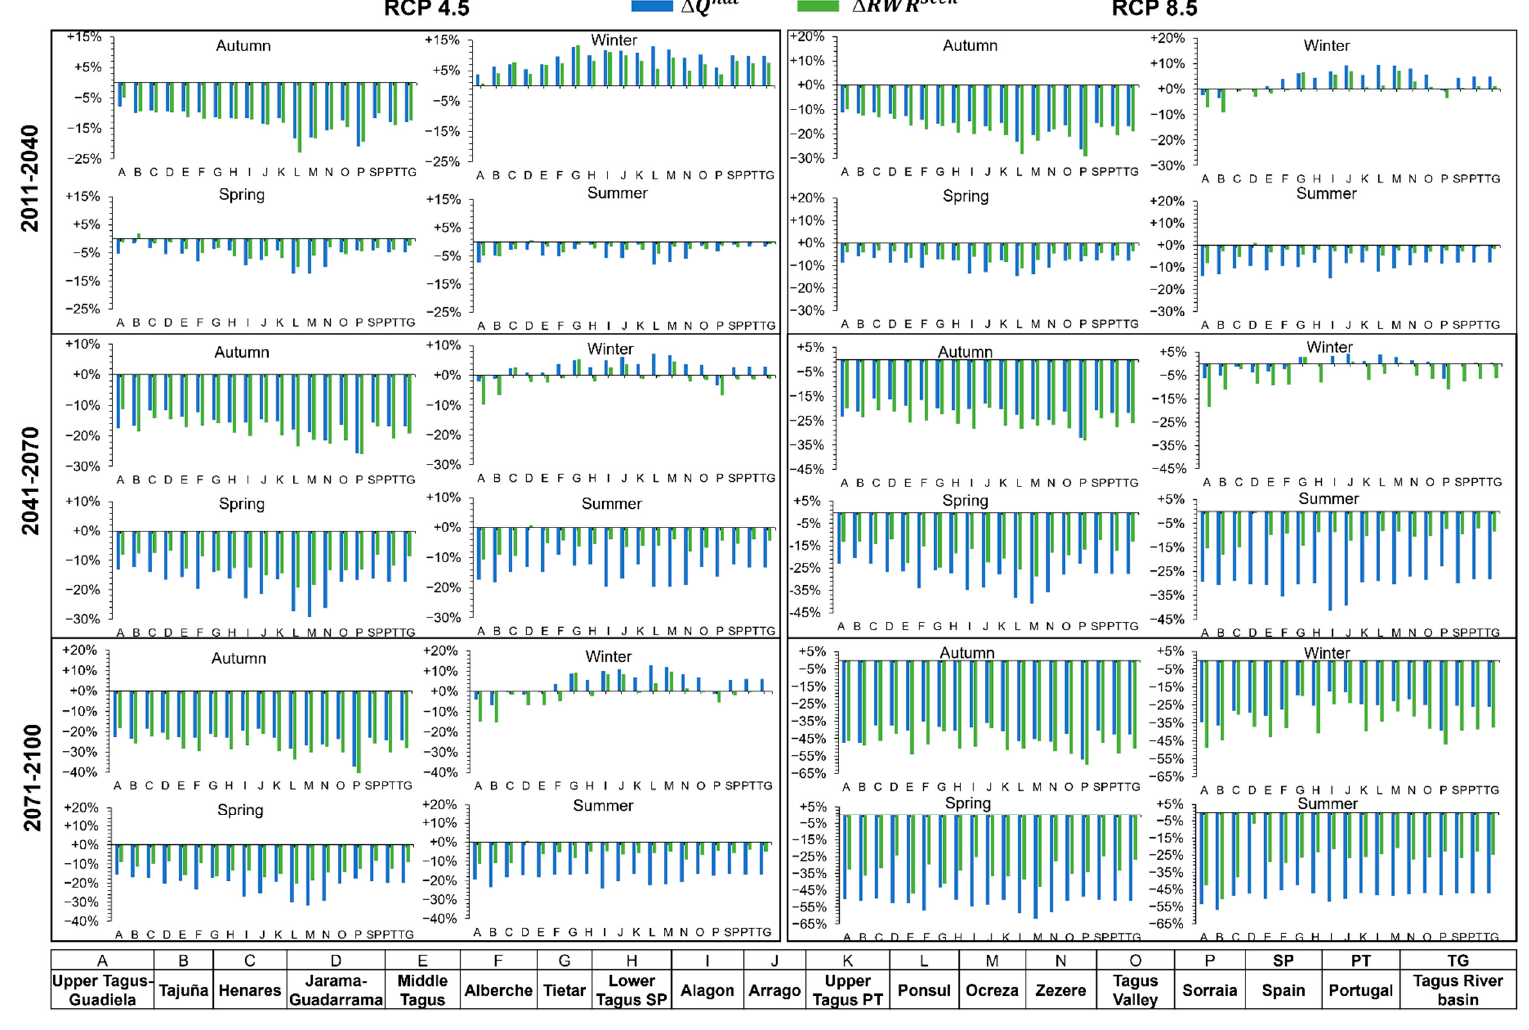
(blue bars) for three future horizons under RCP 4.5 and RCP i , t